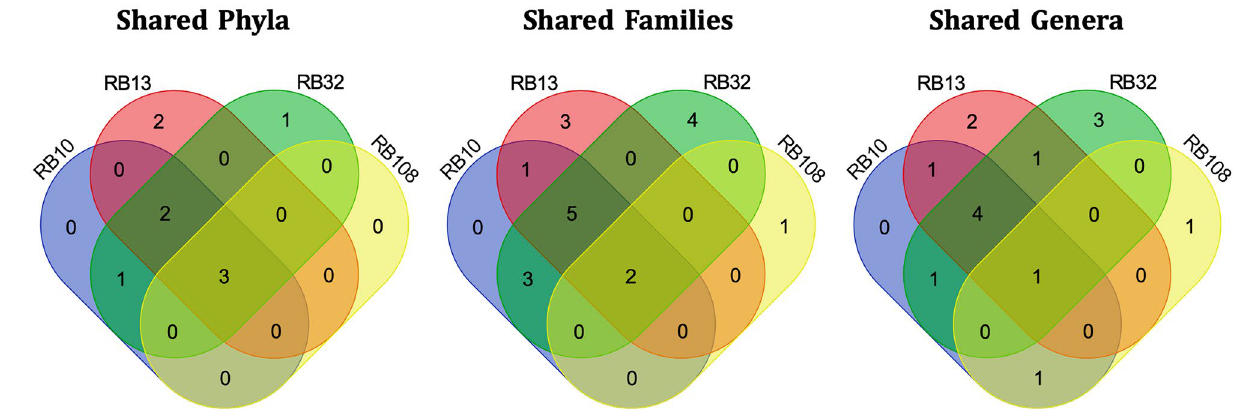
Figure 2. Venn diagrams showing the shared phyla, families and genera according to GTDB classification in the reconstructed MAGs from the hot springs RB10, RB13, RB32 and